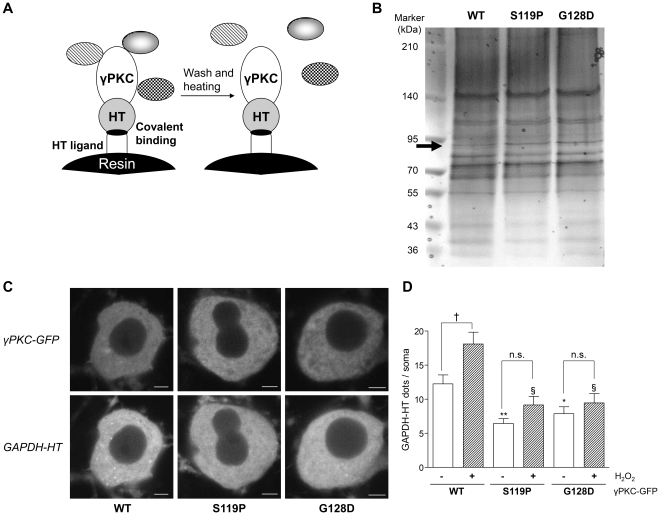
SCA14 mutant γPKC preferably binds with Hsc70 and suppresses CMA in primary cultured PCs.(A) Schematic illustration of pull-down assay using the HT system. Resin-conjugated HT ligands covalently bind to γPKC-HT and harvest γPKC-HT and γPKC-binding proteins from cell lysate. After washes and heat treatment, γPKC-binding proteins are released from the resin, but γPKC-HT itself is still resin-bound through the covalent linkage between HT and the HT ligand. This is a unique feature of the HT pull-down assay, in contrast to other pull-down assays using glutathione S-transferase or immunoprecipitation, and enables us to effectively analyze binding partners of the target protein. (B) Representative silver stained gel of pulled down proteins by the HT pull-down assay and subjected to SDS-PAGE. The HT pull-down assay was conducted using cell lysate from cerebellar primary cultures that expressed WT or mutant (S119P and G128D) γPKC-HT in PCs. The arrow indicates the protein band that was more strongly detected in pull-down samples from cell lysates expressing mutant γPKC-HT than in the WT. Mass spectrometric analysis revealed that this protein is Hsc70. Silver staining gel with pull-down, input and supernatant (Sup) samples is indicated in Figure S5A. (C) Representative fluorescent images of γPKC-GFP (upper panels) and GAPDH-HT (lower panels) in PC somata 21 h after labeling with TMR-HT ligand. PCs coexpressed GAPDH-HT and either WT (left), S119P (center) or G128D (right) mutant γPKC-GFP. We evaluated GAPDH-HT lysosomal translocation in PCs not displaying aggregation of mutant γPKC-GFP. Bar = 5 µm. (D) Quantitative analyses of GAPDH-HT lysosomal translocation in PC somata in the absence (open bars) or presence (hatched bars) of 100 µM H2O2. Mutant versions of γPKC-GFP (S119P and G128D) significantly decreased the number of GAPDH-HT dots (* p<0.05, ** p<0.001 vs PCs expressing WT γPKC-GFP without H2O2, unpaired t-test, n = 45, and § p<0.001 vs PCs expressing WT γPKC-GFP with H2O2, unpaired t-test, n = 45). While H2O2 significantly increased the number of GAPDH-HT dots in PCs expressing WT γPKC-GFP († p<0.01, unpaired t-test), it failed to increase the number of GAPDH-HT dots in PCs expressing mutant γPKC-GFP (n.s.: not significant (p>0.05), unpaired t-test).